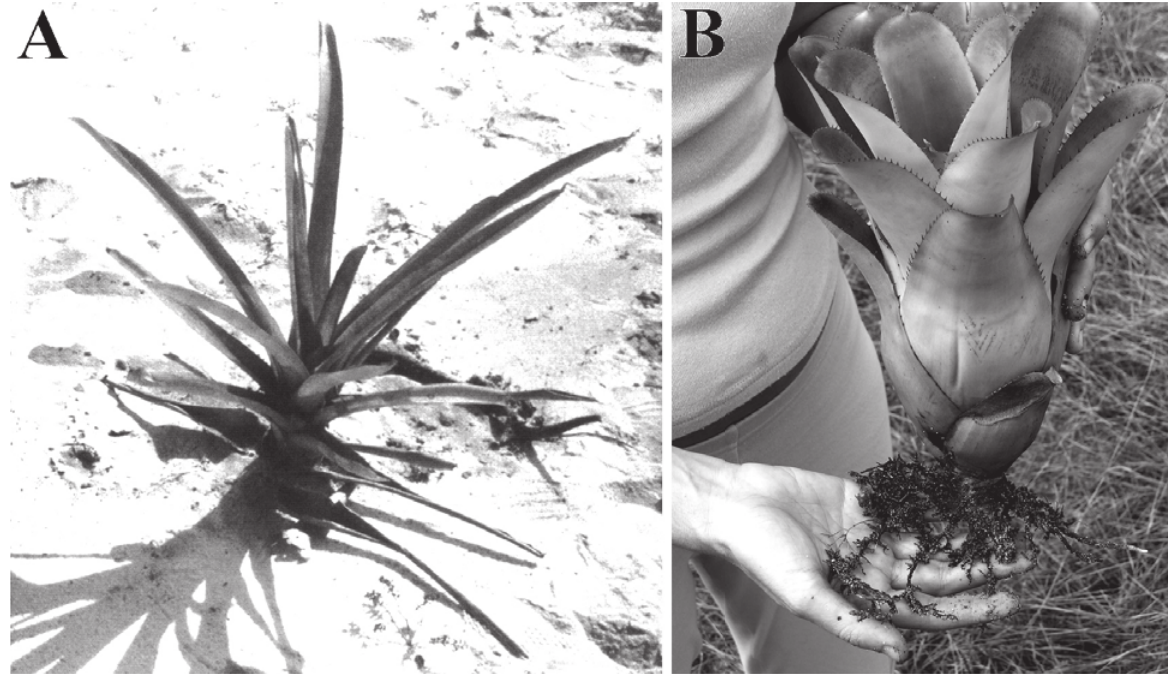
Figure 1 - Shade (A) and sun (B) rosettes of Neoregelia cruenta under natural conditions. Note differences in the rosette